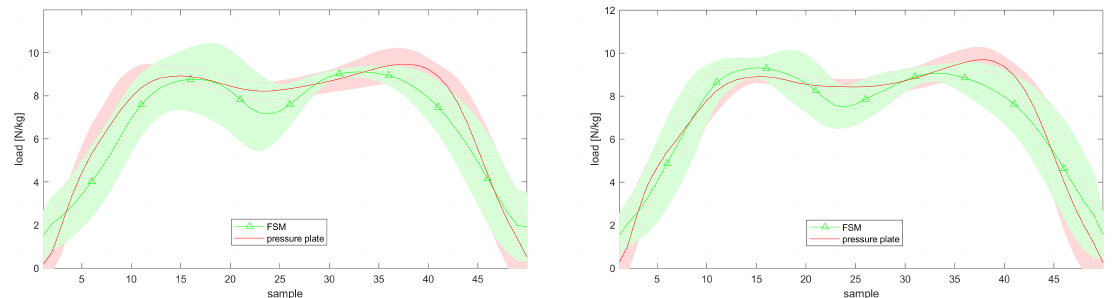
Figure 7. vGRF trajectories for the left and right foot resulting from FSM (green indication) compared to the pressure plate (red indication) normalized by the total body weight; the lines illustrate the mean vGRF values taken from multiple gait cycles (from heel-strike to toe-off) with the respective variations of one standard deviation.